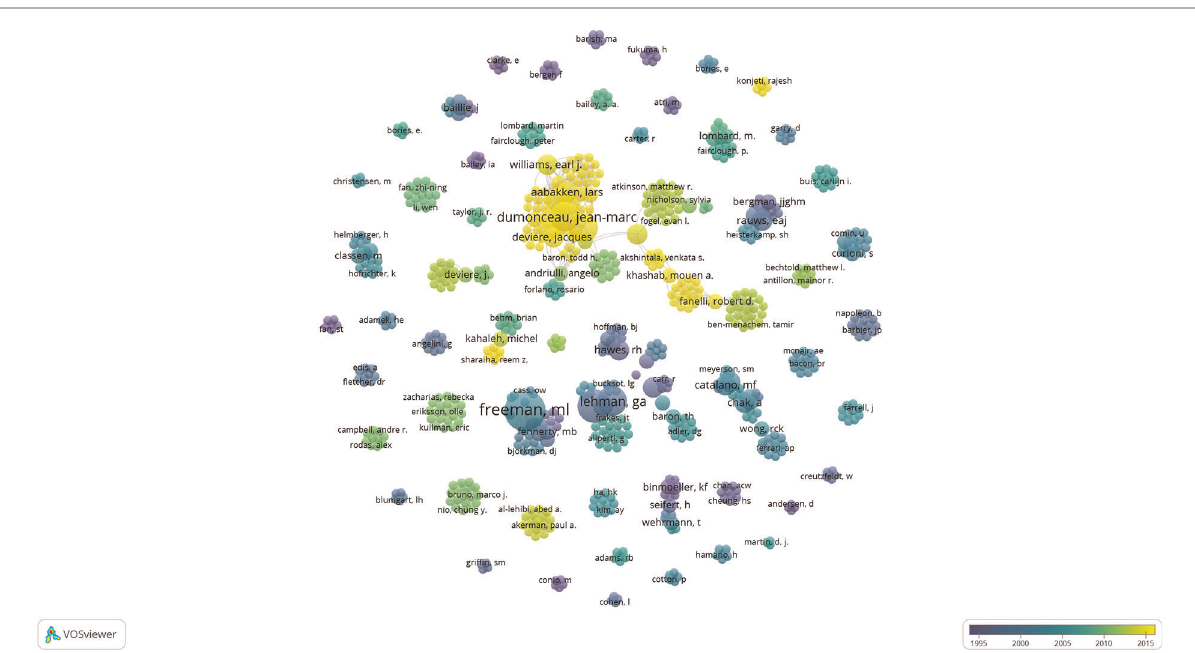
FIGURE 4 VOSviewer co-authorship map illustrating author density and the existence of clusters among all authors of the 100 most-cited articles. Each node represents a different author, and the node size is proportional to the number of publications. The color represents the average year the author published.